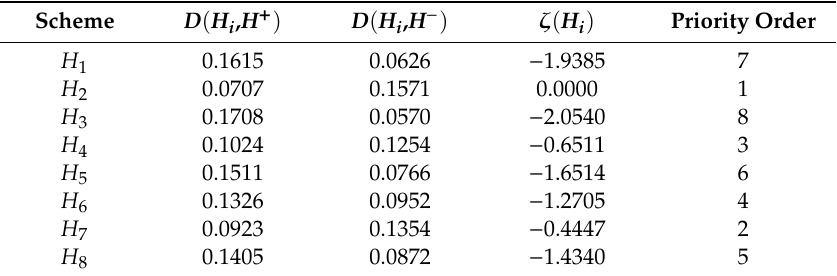
Table 6. Decision results of Pythagoras fuzzy TOPSIS method.